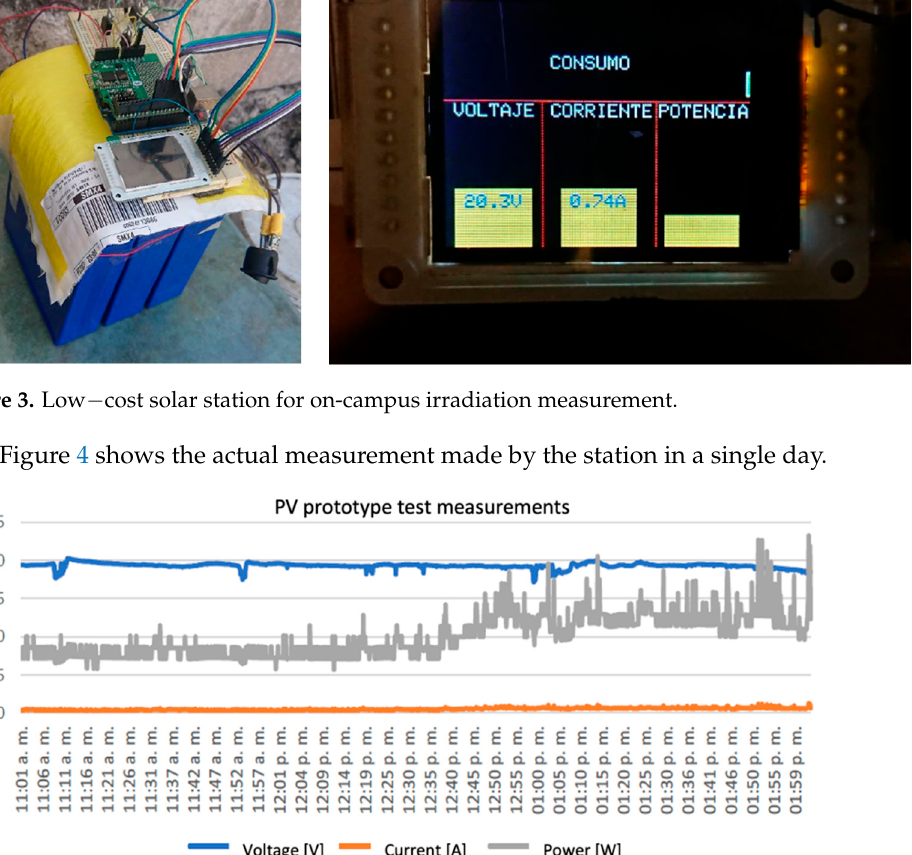
Figure 2. System’s life cycle carbon emissions reduction potential.